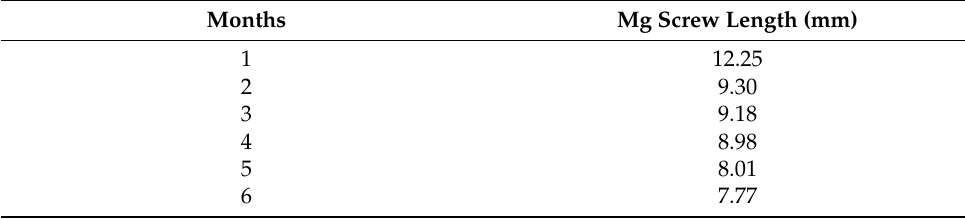
Figure 21. Longitudinal section CT scans recorded ( a ) 1 month, ( b ) 2 months, ( c ) 3 months, ( d ) 4 months, ( e ) 5 months, and ( f ) 6 months after surgery. Table 2. The remain length of the Mg